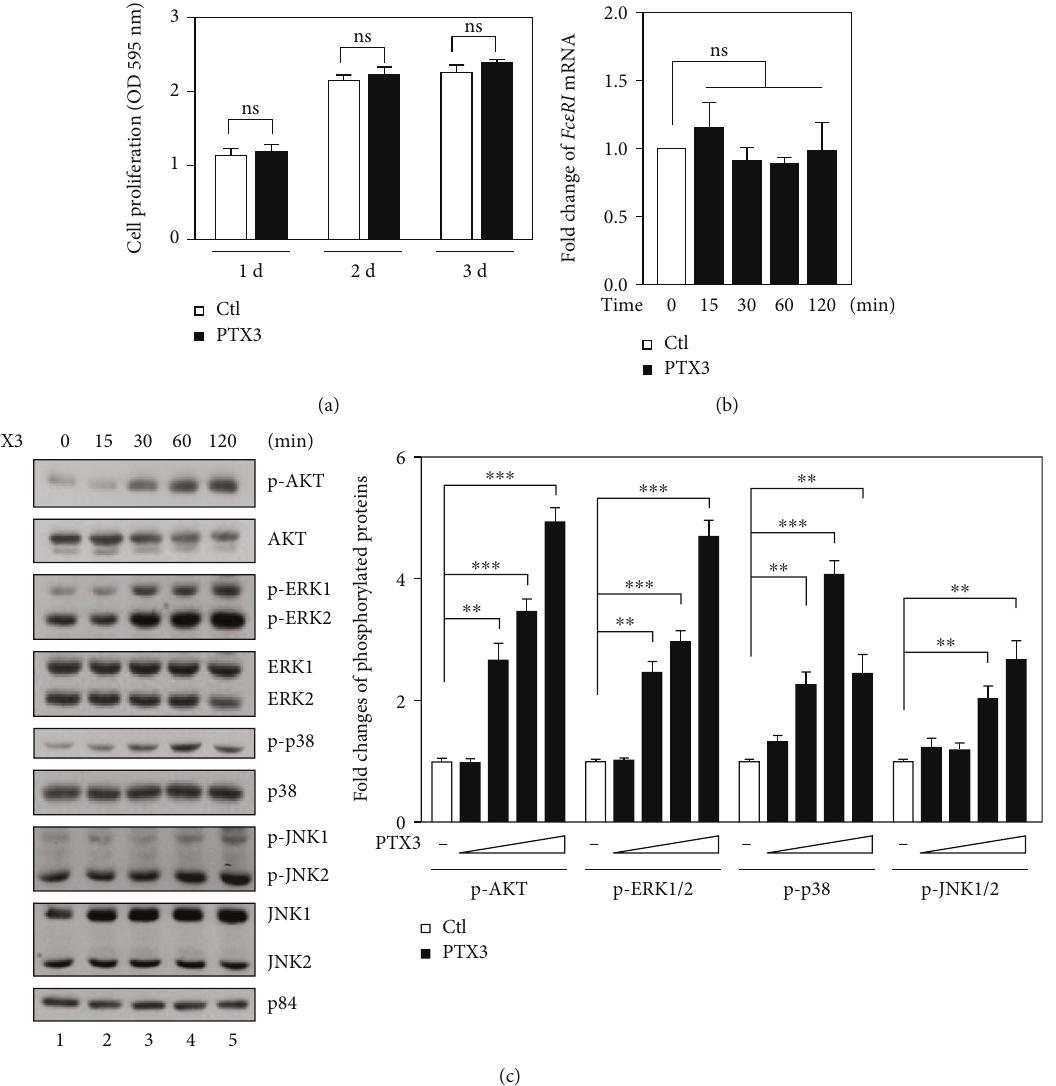
Figure 3: PTX3 contributes to Fc ε RI-mediated signaling pathways in RBL-2H3 cells. (a) RBL-2H3 cells were treated with PTX3 (300ng/ml) for 1, 2, or 3 days. Statistical analysis of cell proliferation was determined by MTT assay. (b) E ff ects of PTX3 on the mRNA level of Fc ε RI in PTX3- treated RBL-2H3 cells were determined by qPCR. (c) RBL-2H3 cells were incubated with PTX3 for 15, 30, 60, and 120min. Total lysates were harvested for western blot analysis using antibodies as indicated. The quantitative analysis of phosphorylated proteins is shown in the